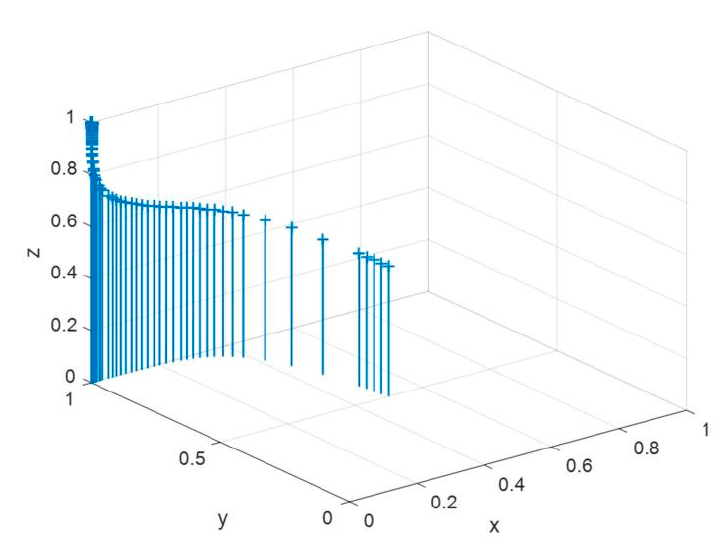
Figure 8. Three-dimensional diagram of evolutionary path at stable point (0, 1, 1).